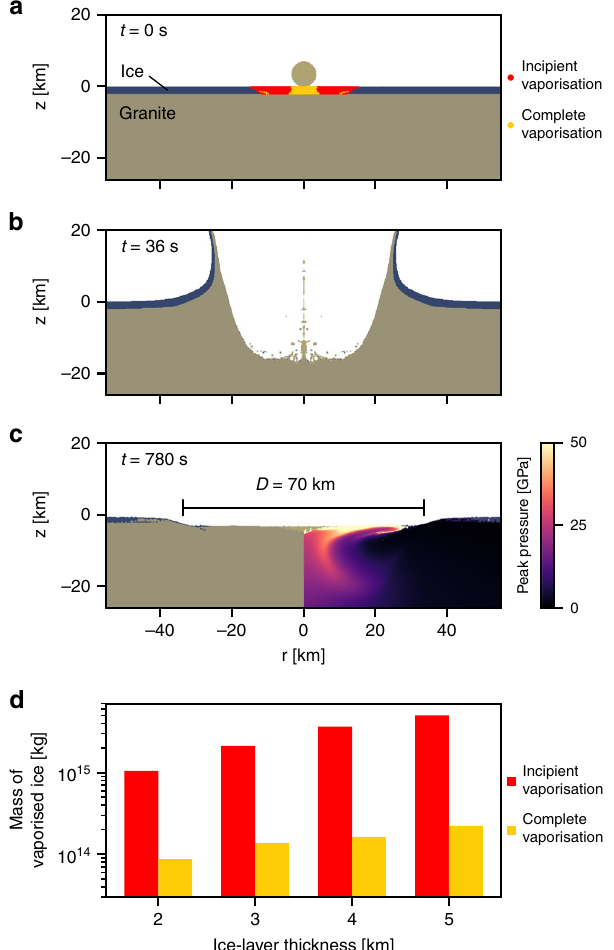
Fig. 5 Evolution of an impact crater in an ice covered continent. Snapshots of the iSALE model with a 2-km-thick ice sheet showing a the initial conditions, b the transient crater and c the fi nal crater. Superimposed on a is the initial position of tracer particles which were shock-heated to the critical entropy required to begin vaporisation (incipient vaporisation, red) and to completely vapourise ice (complete vaporisation, yellow). The colour scale on the right-hand side of c shows the peak shock pressure in the granite basement. d The calculated mass of ice shock-heated to the critical entropy for incipient and complete vaporisation, as a function of initial ice thickness. In each impact, the impactor size was 7 km and resulted in a fi nal crater diameter of ~70